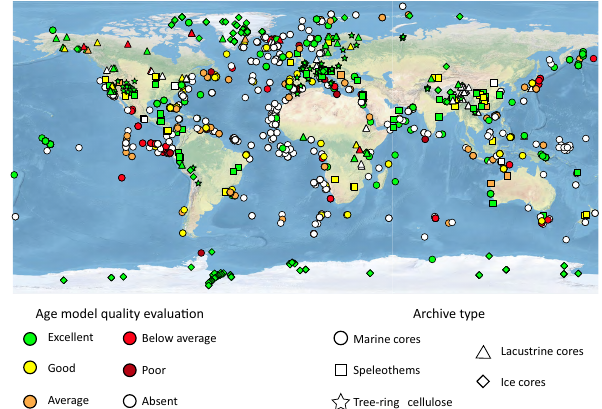
Figure 5. Diagram showing the distribution of ice cores, tree-ring, lacustrine, speleothem and marine records as a function of coring site elevation.